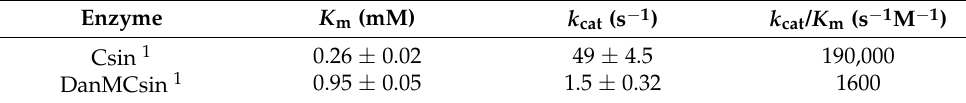
Table 1. Kinetic parameters Csin and DanMCsin for Suc-Ala-Ala-Phe- p NA. Enzyme